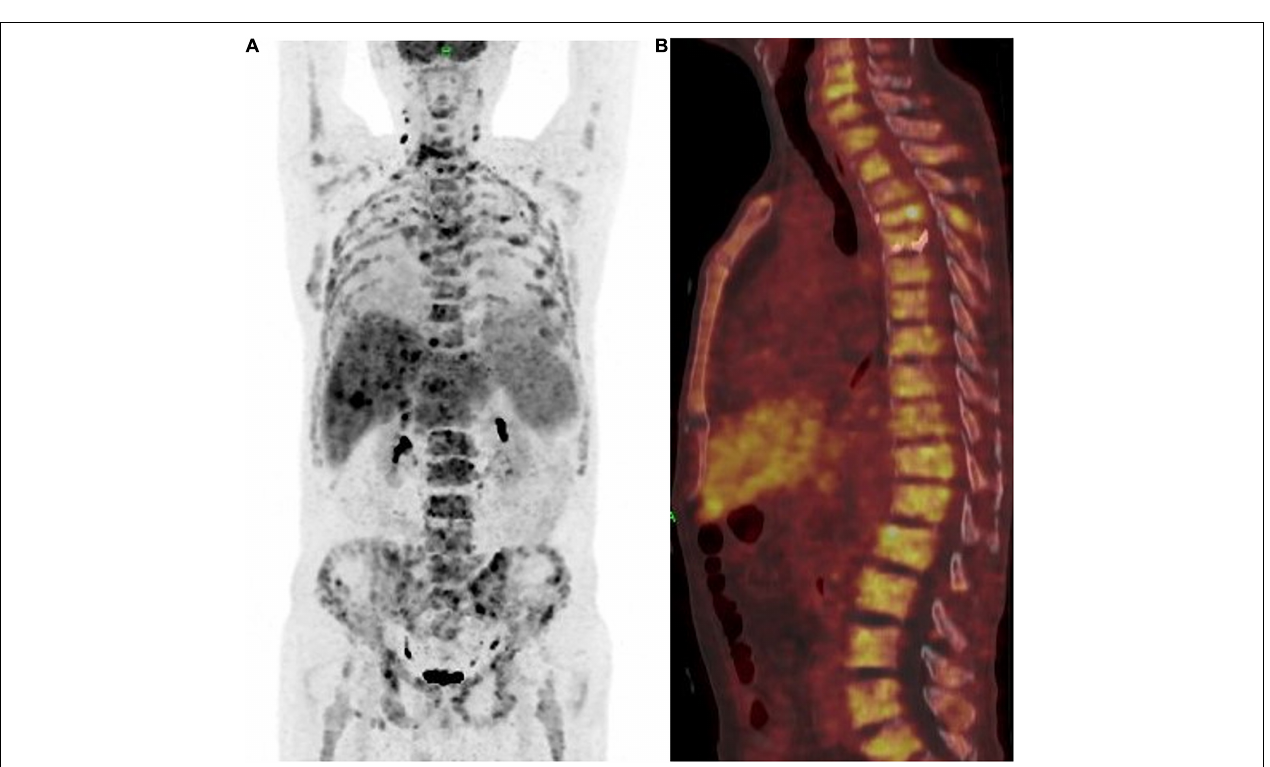
FIGURE 4 | (A) Positron emission tomography and computed tomography showed the patient achieved partial response (PR) according to the mRECIST1.1 on metastatic lesions. (B) PET-CT showed a whole vertebra metastatic Primary EMPD, showing that a most obvious decrease of SUV from 18.9 to 5.3.